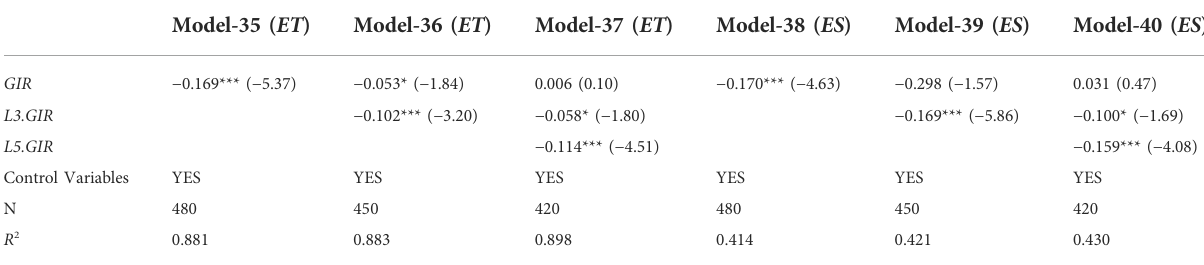
TABLE 8 Results of robustness